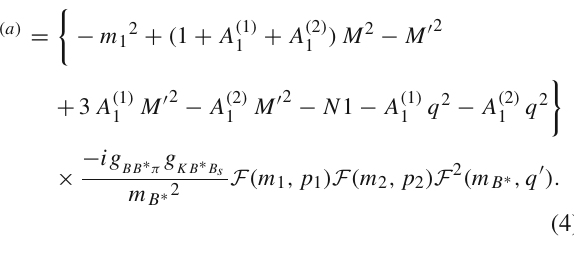
with ˆ N 1 = x 1 ( M 2 − M 02 ), (cid:3) ˆ 2 − x = x N 2 q 1